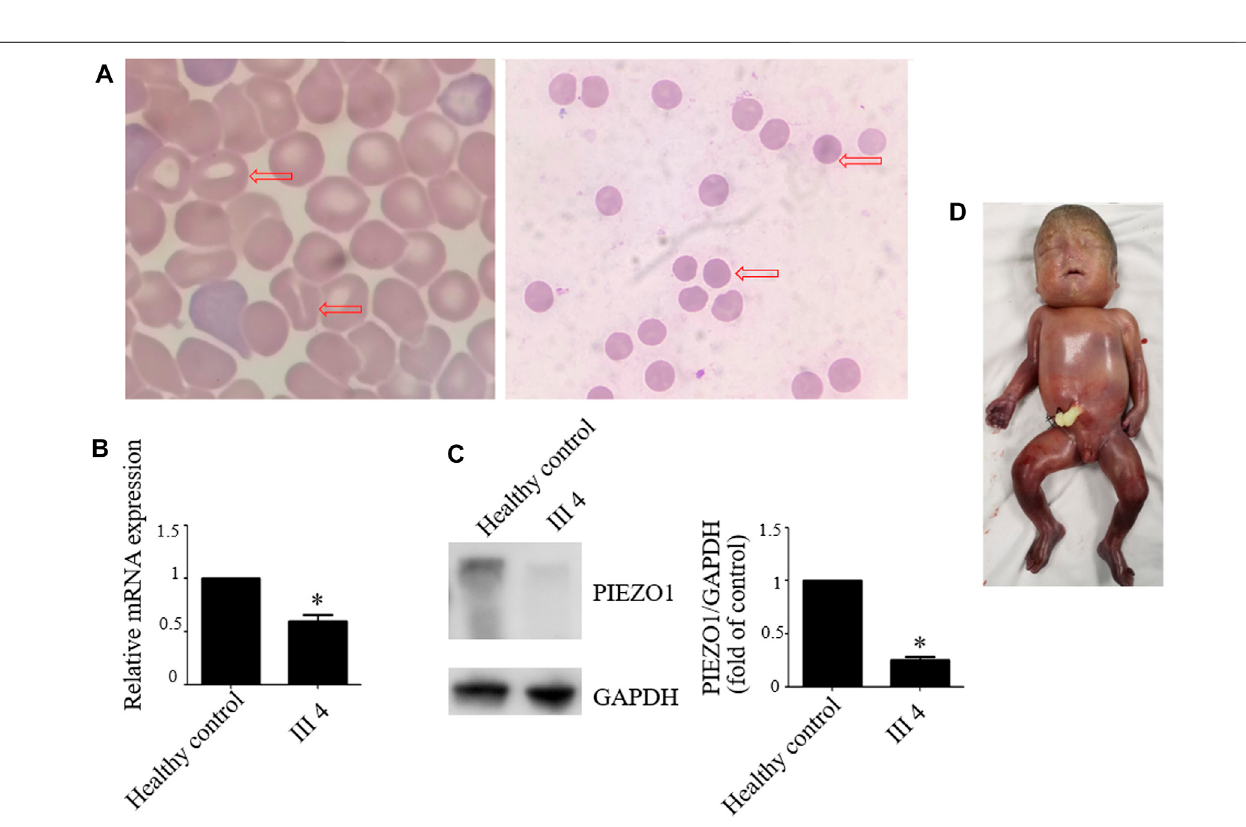
Frontiers in Genetics |